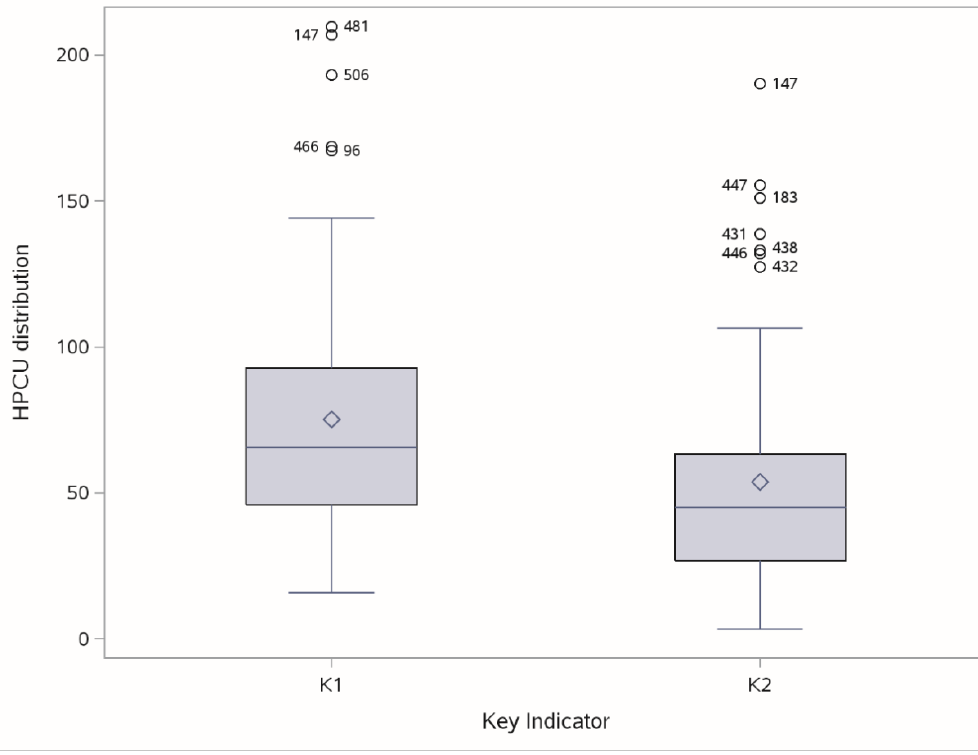
Table 3. Summary of the admission Process of the 118 registered HPCSs.